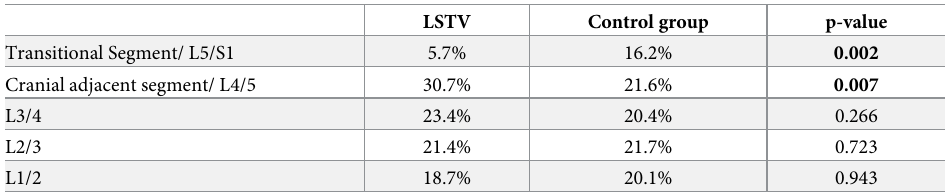
Table 4. Distribution of lumbar mobility to lumbar